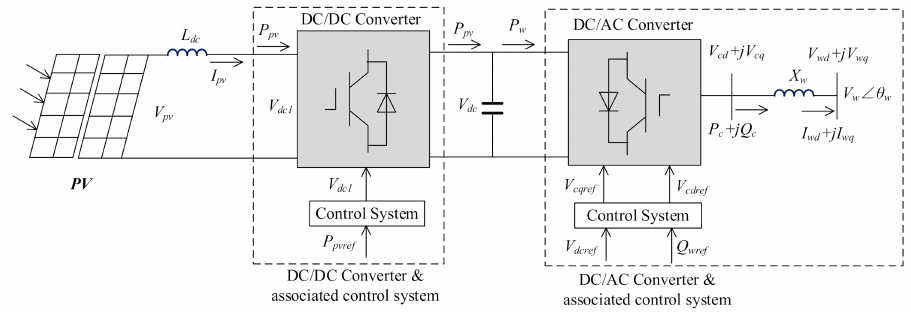
Figure 3. Physical configuration of an FCPV interconnected to the AC power